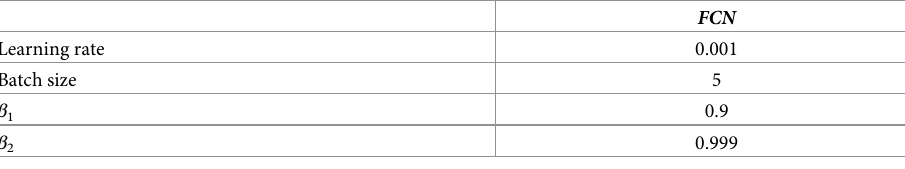
Table 2. Hyperparameters of the semantic segmentation neural network.